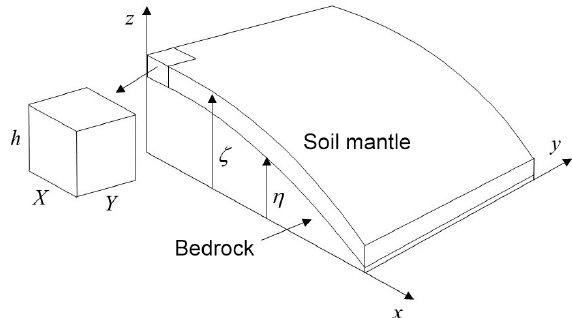
Figure 1. Definition diagram of soil-mantled hillslope with me- chanically active soil thickness h = ζ − η , and cutout soil element with dimensions XYh . Bedrock material is continually transformed into soil by chemical and mechanical processes, and soil particles are transported downslope by creep or surface